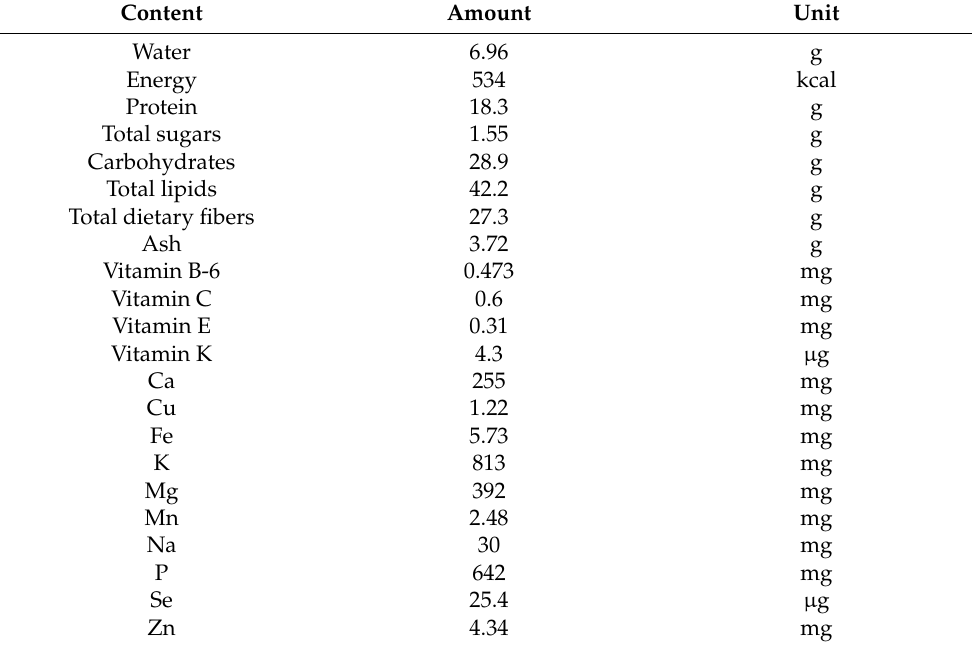
Table 2. Flax seed nutritional value per 100 g of seed. Data retrieved from